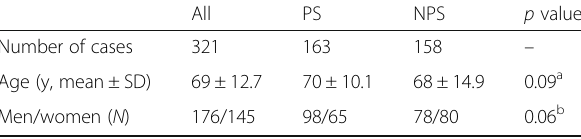
Table 1 Patient characteristics (analysis